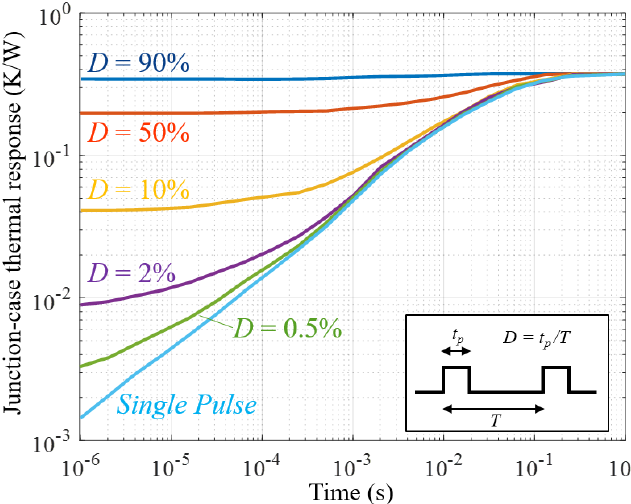
Figure 13. Thermal impedance between the SiC MOSFET junction and the SiC power module case (reference CCS050M12CM2).